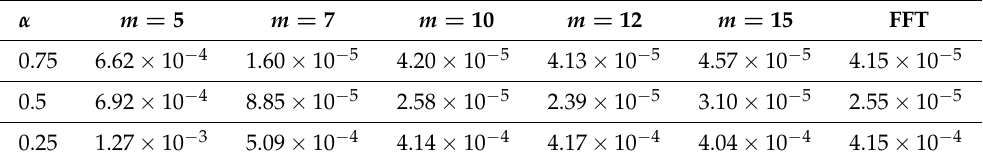
Table 1. The AAA algorithm: errors of the solution of the discrete scheme (19) for α = 0.75,0.5,0.25 and a sequence of parameters m . The column FFT defines errors of the spectral solver.